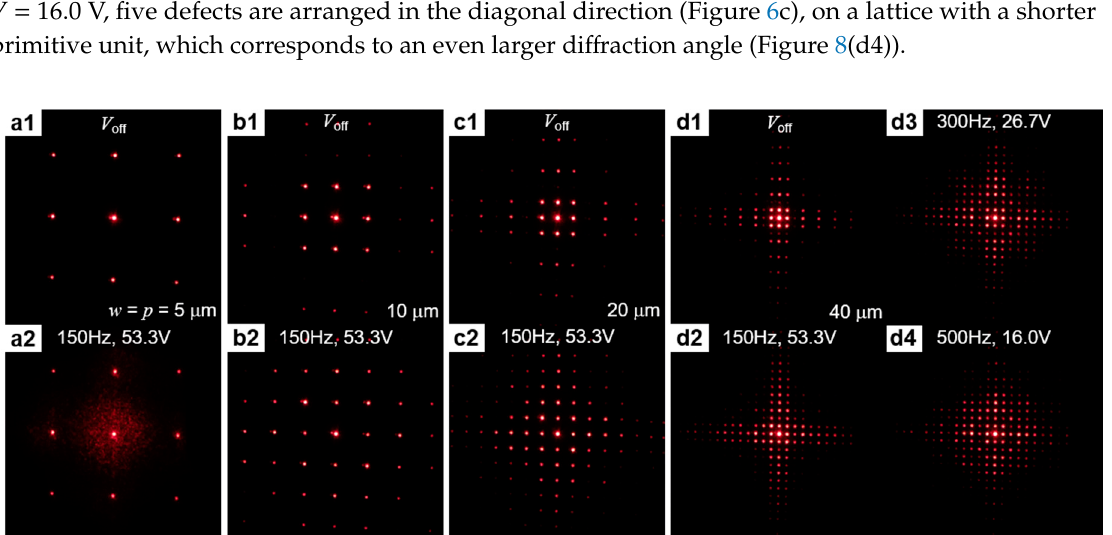
Figure 8. Diffraction patterns with square-shaped pillars: ( a ) w = p = 5; ( b ) w = p = 10; ( c ) w = p = 20; and ( d ) w = p = 40 μ m. ( a1–d1 ) Voltage-off state; ( a2–d2 ) f = 150 Hz, V = 53.3 V; (d3) f = 300 Hz, V = 26.70 V; and ( d4 ) f = 500 Hz, V = 16.0 V. Cell thickness is d = 5.6 μ m and pillar height is h = 2 μ m.